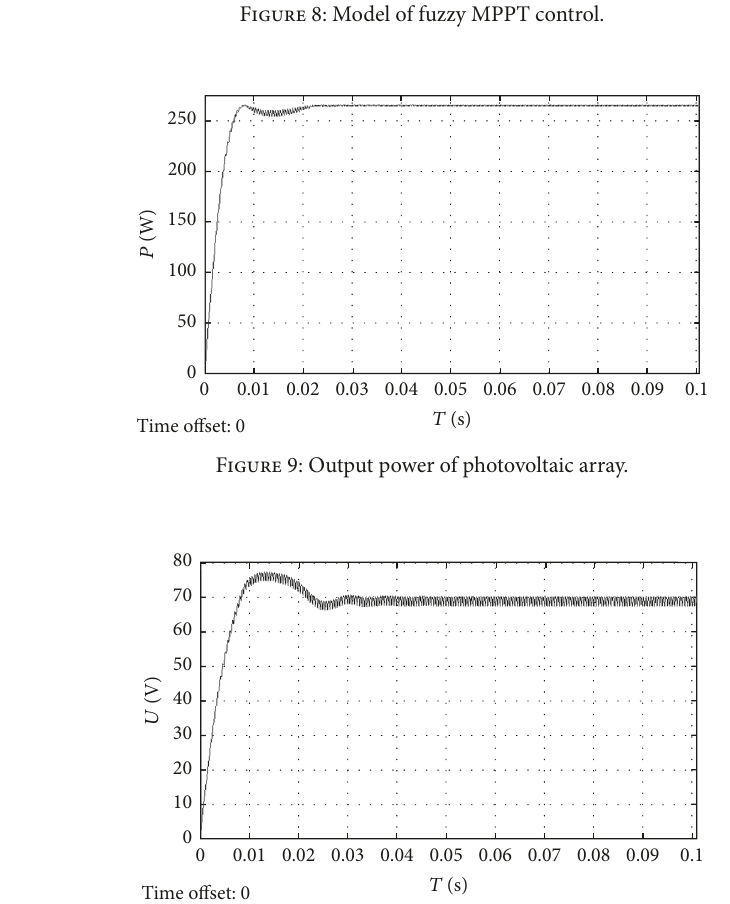
Figure 10: Output voltage of photovoltaic